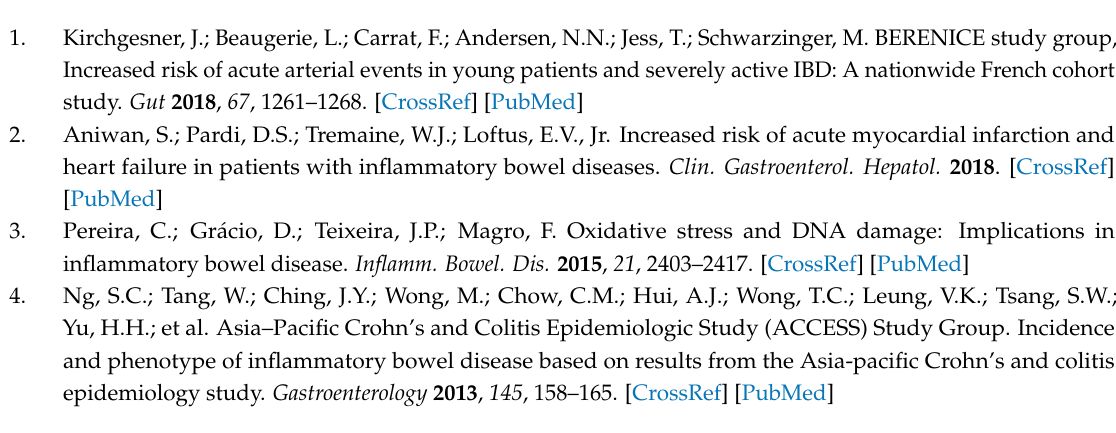
Figure A1. CONSORT 2010 flow diagram.